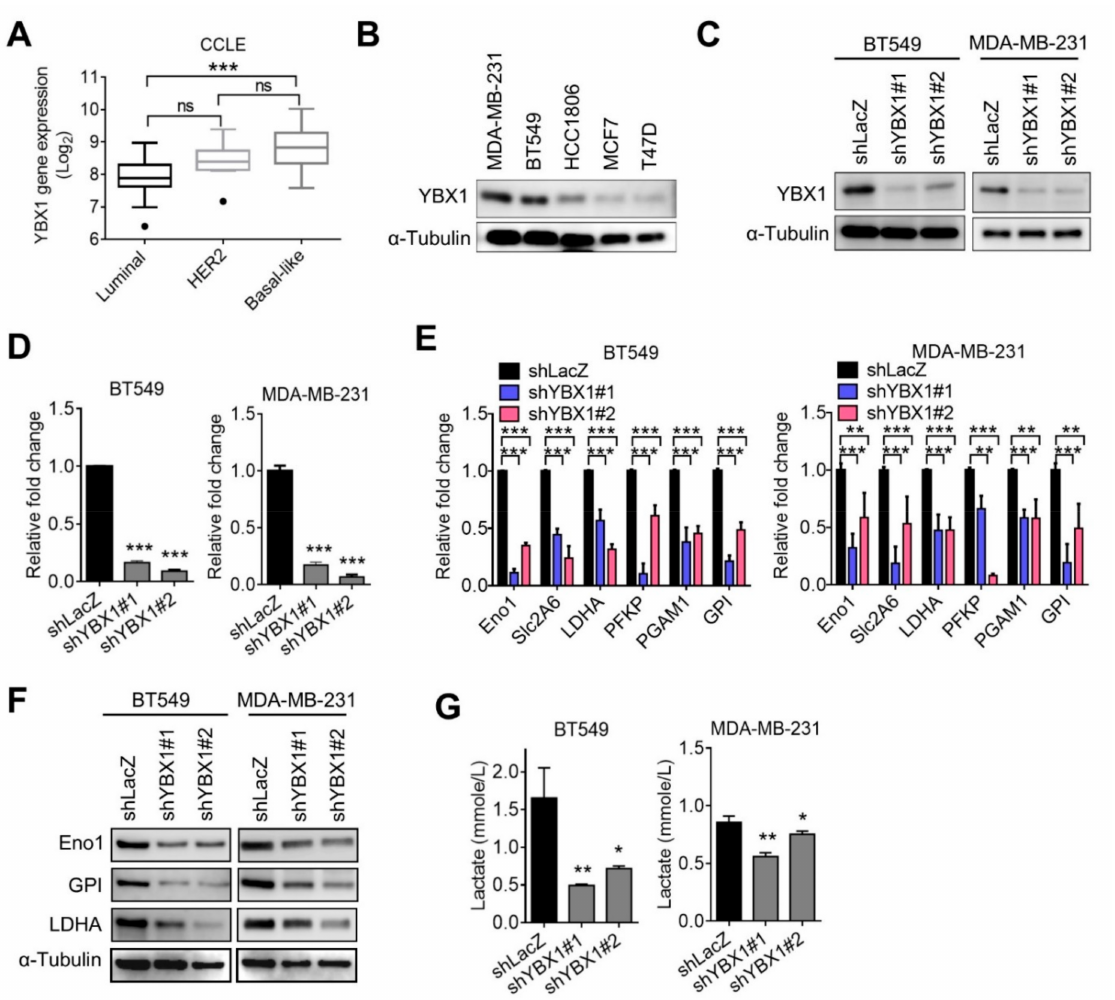
Figure 5. YBX1 regulated glycolysis genes expression. ( A ) Expression levels of YBX1 in luminal, HER2, and TNBC cell lines according to the CCLE breast cancer dataset. *** p < 0.001 as determined by an ANOVA. ns, not significant. ( B ) Western blot analysis of YBX1 protein levels in breast cancer cell lines. ( C and D ) Knockdown efficiencies of YBX1 shRNAs in MDA-MB-231 and BT549 cells, as measured by Western blot and RT-qPCR analyses. ( E ) RT-qPCR analysis of glycolysis signature expression in YBX1-knockdown MDA-MB-231 and BT549 cells. ( F ) Western blot analysis of glycolysis protein levels in YBX1-knockdown MDA-MB-231 and BT549 cells. ( G ) Production of lactate production in YBX1-knockdown MDA-MB-231 and BT549 cells, as measured by a lactate assay kit. * p < 0.05, ** p < 0.01, and *** p < 0.001 as determined by unpaired t